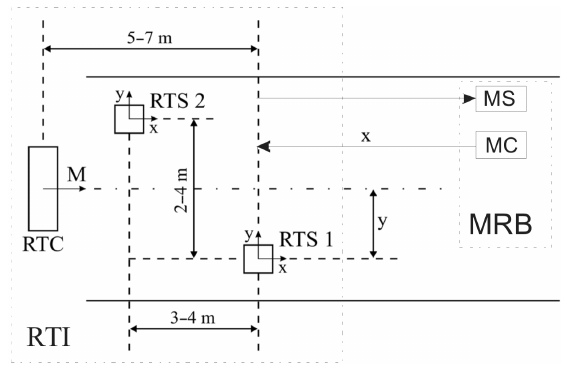
Figure 3. Miner’s location emergency system (MILES) functional diagram.